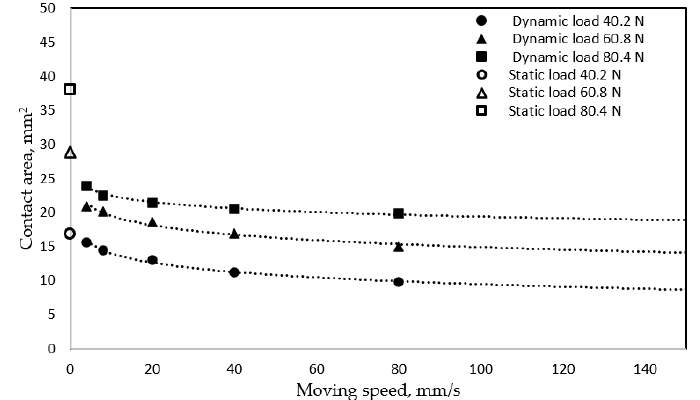
Figure 13. Rubber-wheel real contact area on dynamic condition of three variations applied normal load 40.2 N, 60.8 N, and 80.4 N, respectively.